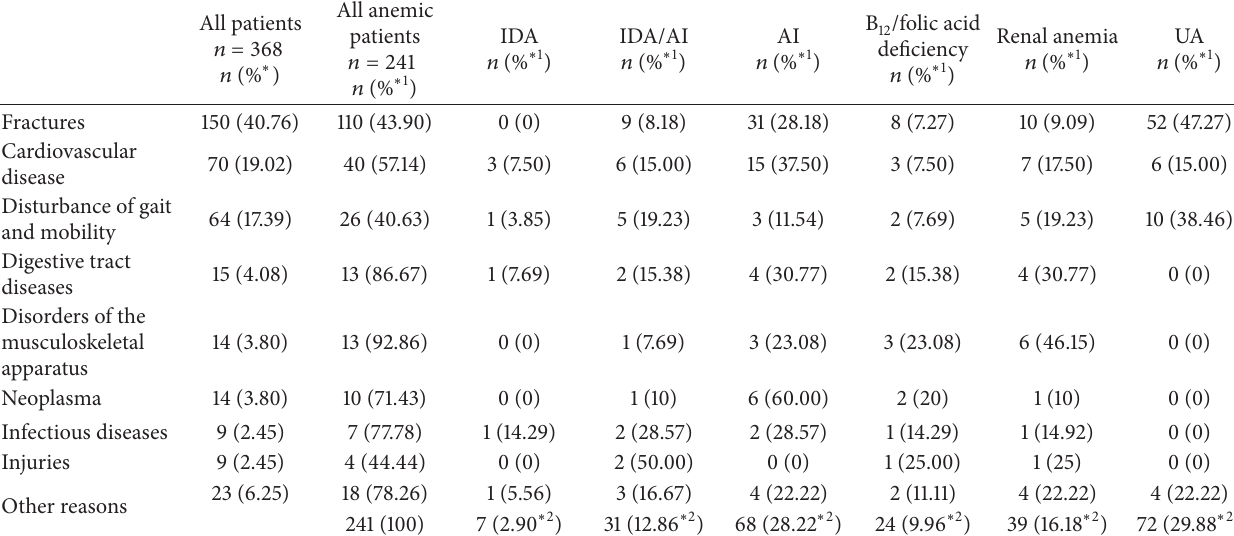
Table 1: Anemia subtypes according to main reason for hospitalization.